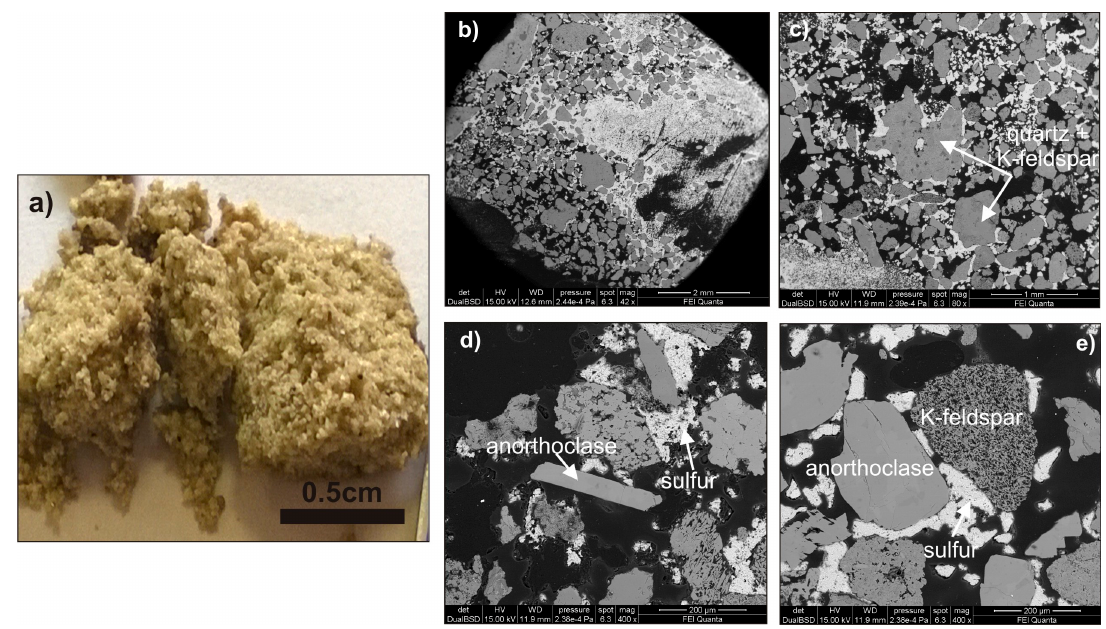
Figure 8. ( a ) macroscopic rock image of ROV6 sample. Sand is composed of quartz, K-feldspar, anorthoclase and plagioclase cemented by sulfur.; ( b – e ) SEM images showing the texture of minerals forming the sample.